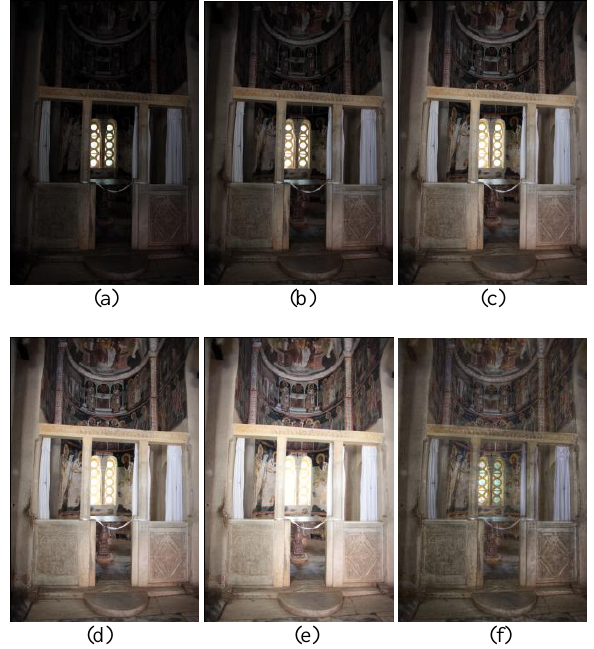
Figure 1: Scene1, (a) – (e) 5 frames with exposure values from - 2EV to +2EV (f) tone mapped image according to Mantiuk’s algorithm (Mantiuk et al., 2006).